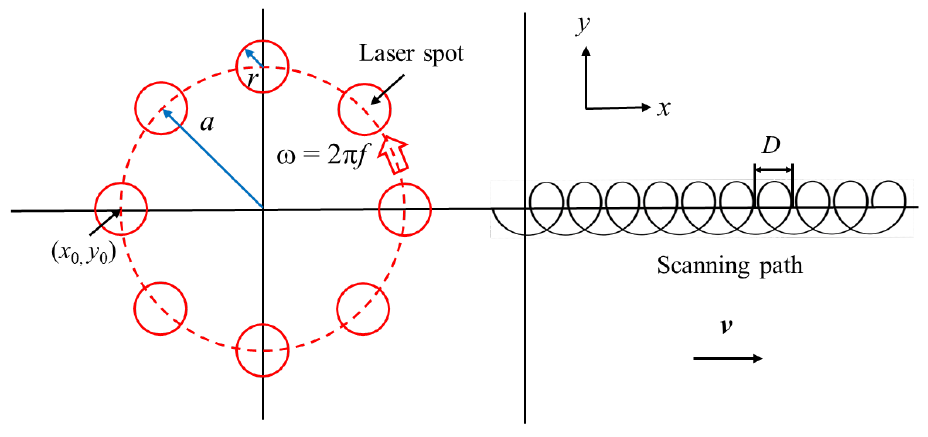
Figure 4. Heat source model and moving path.